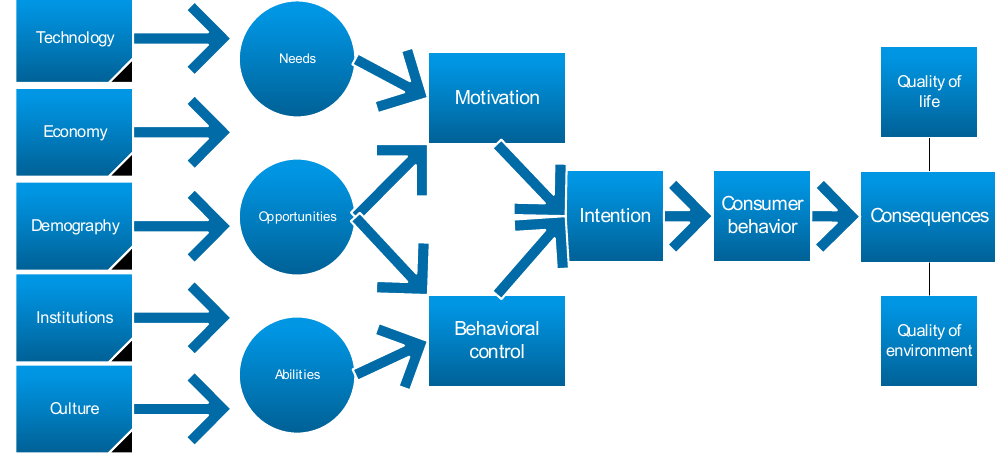
Figure 2. The needs opportunities ability (NOA) model of consumer behavior, modified from [54].